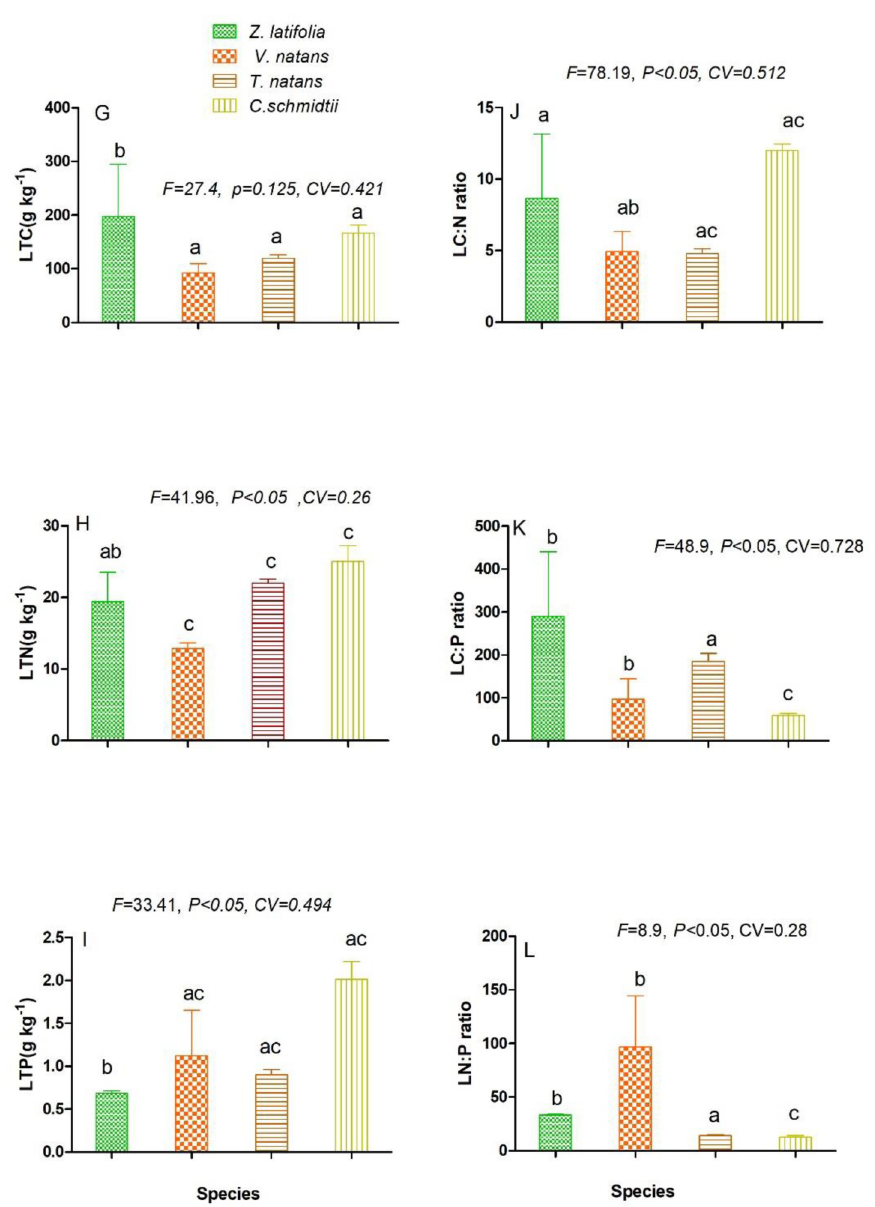
Fig 3. Ecological stoichiometric characteristics of leaf C, N, P and their mass ratio among the four studied macrophytes species. LT-leaf total carbon-(3G), LTN-leaf total nitrogen-(3H), LTP-leaf total phosphorus-(3I), LC: N leaf C: N ratio(3J), LC: P leaf C: P ratio,(3K), LN: P leaf N: P ratio(3L). Figures represent Mean ± SD, different letters show significant difference at p < 0.05.